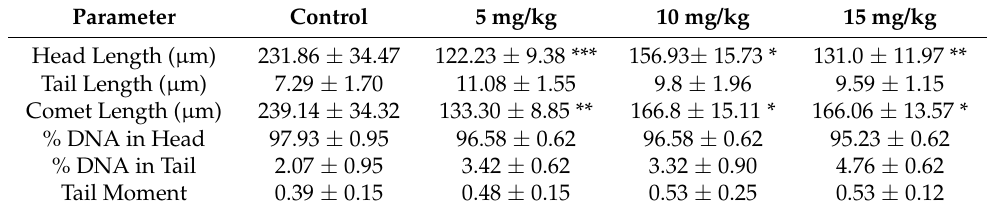
Table 3. Mean ± SEM of DNA damage in control and Cd treated adult rats after 17 days of treatment.